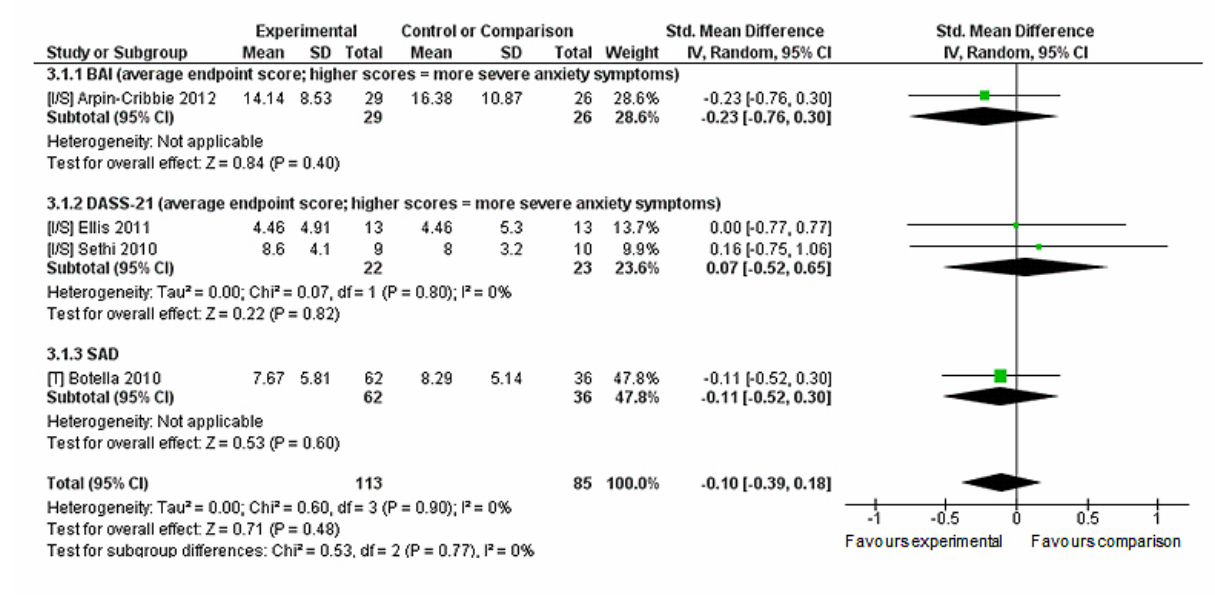
Figure 7. Sensitivity analysis of post-intervention anxiety outcomes for intervention compared to comparison intervention.